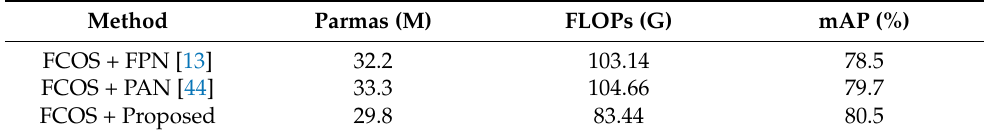
Table 7. Ablation study of the proposed feature pyramid structure.